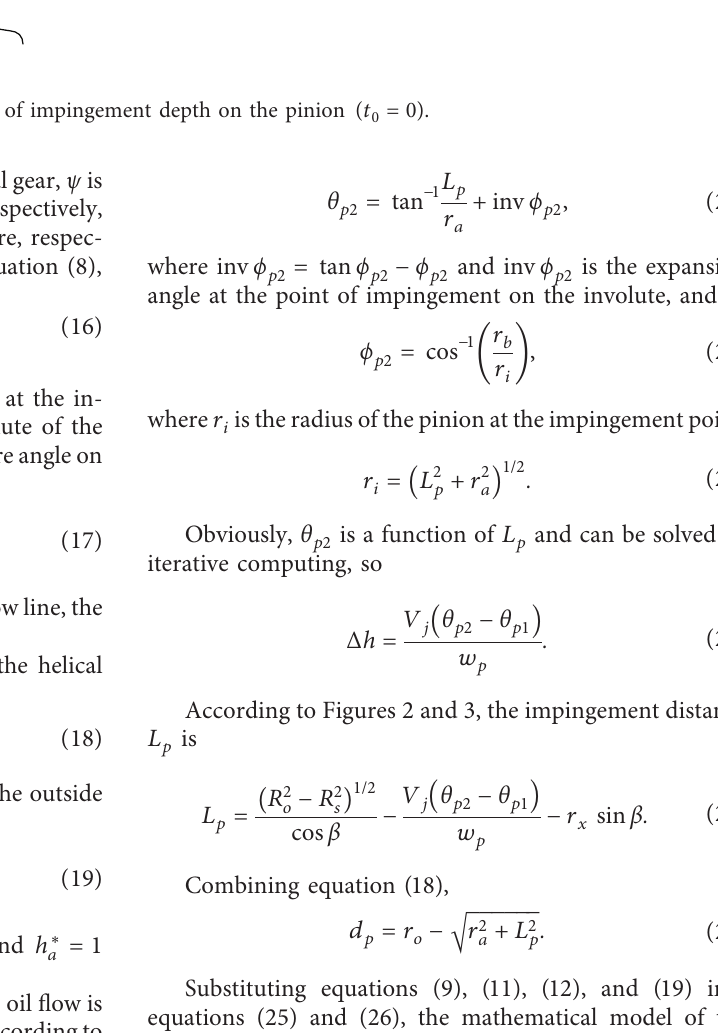
Figure 2: Diagram of impingement depth on the pinion ( t